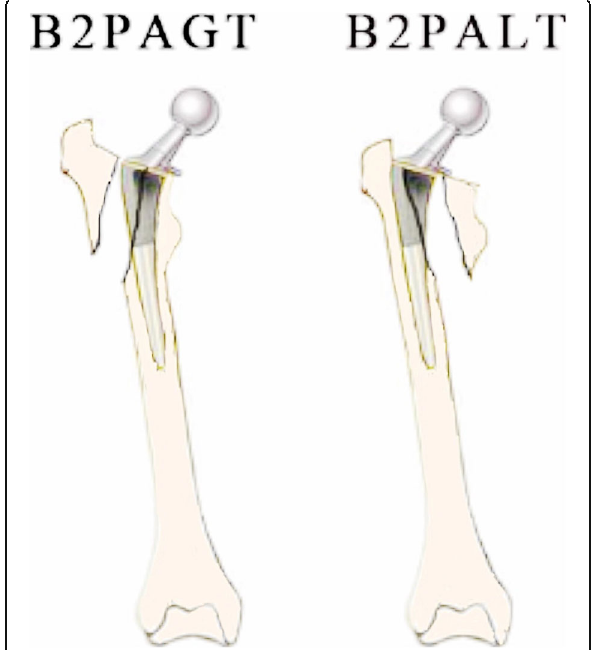
Fig. 6 The Modified Unified Classification System [10]: B2PALT/ B2PAGT was defined as fracture in trochanter region including a segment of the proximal medial/lateral femoral